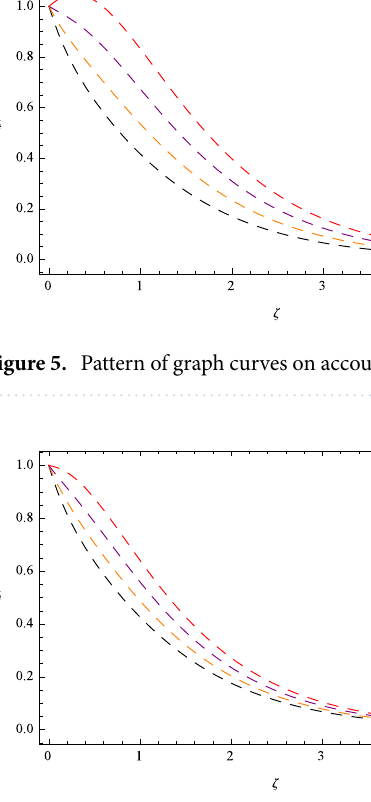
Figure 6. Pattern of graph curves on account of (cid:31) 4 .